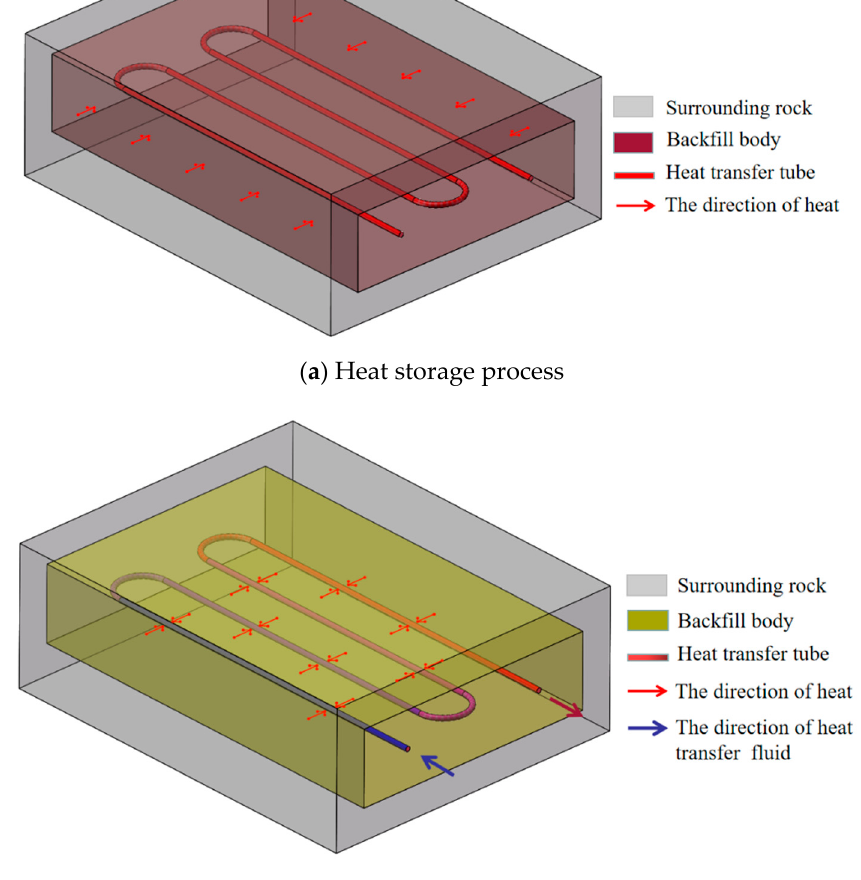
Figure 2. The working process of the phase-change heat storage backfill body.